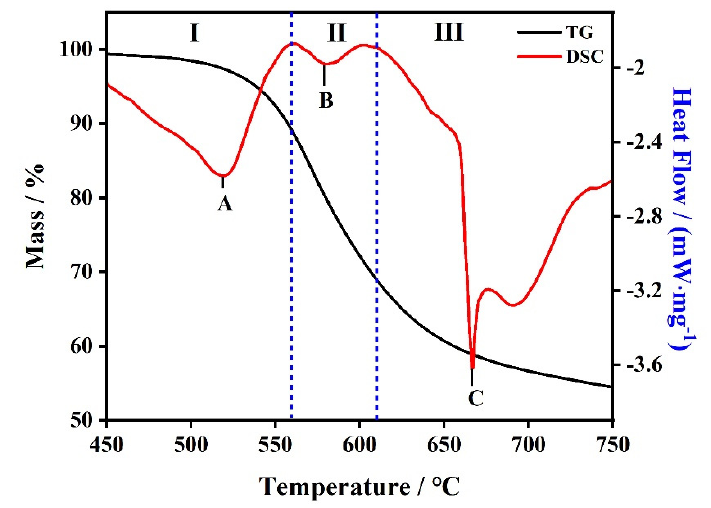
Figure 1. TG − DSC curves of PI under an N 2 atmosphere.